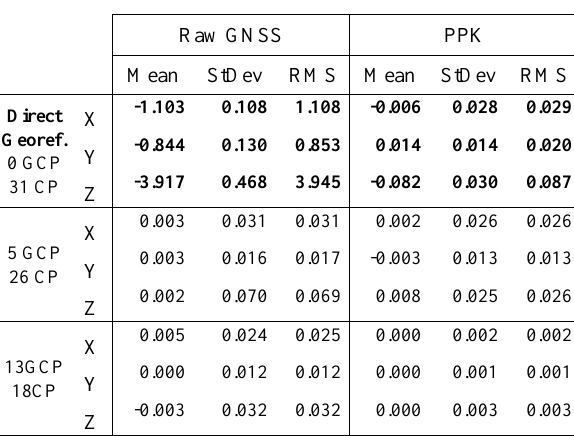
Table 2. 3D positional accuracies in terms of Mean, Standard Deviation (StDev) and Root Mean Square Error (RMS) using a direct georeferencing approach and the two GPCs/CPs configurations shown in Figure 10, with and without PPK processing.